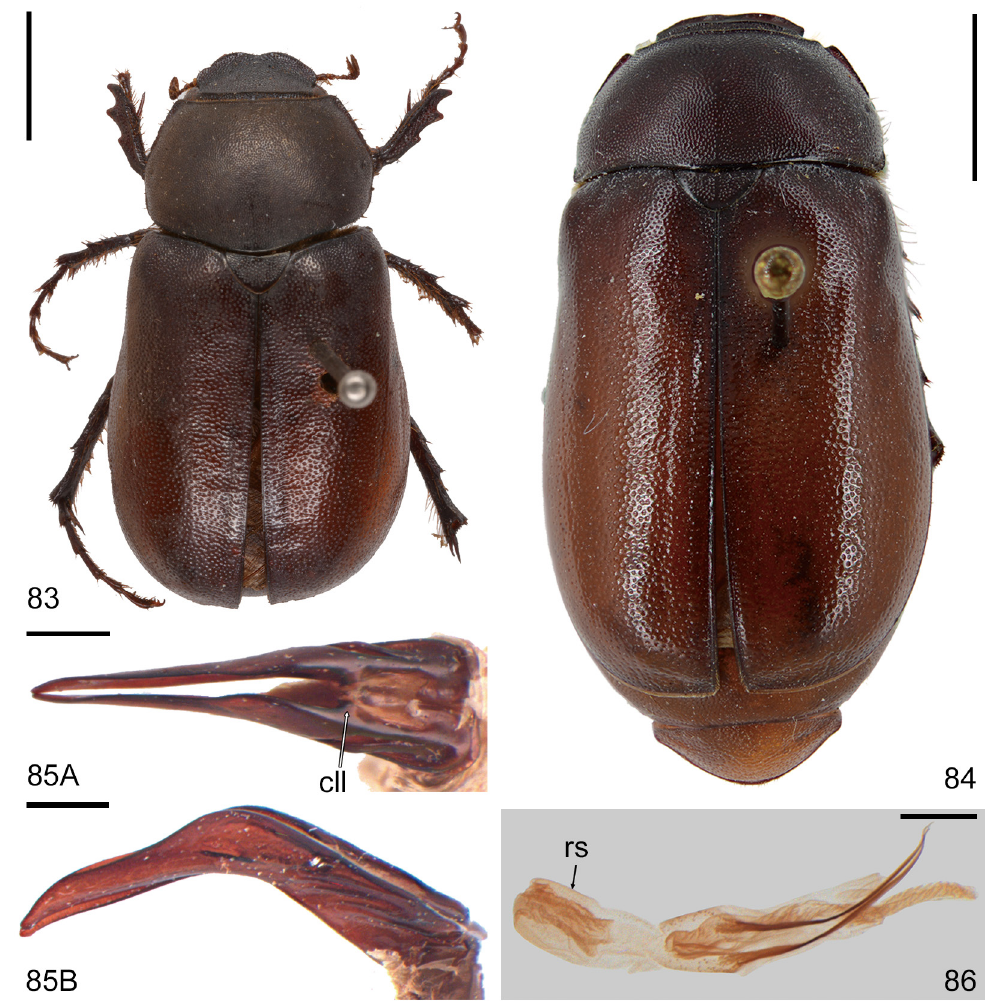
Figs 83–86. 83 . Miridiba sinensis (Hope, 1842), lectotype, ♂ (BMNH). Habitus in dorsal view. 84– 86 . M. pseudosinensis Keith, 2010, holotype, ♂ (DKC). 84 . Habitus in dorsal view. 85 . Parameres in dorsal (A) and lateral (B) views. 86 . Endophallus (everted) and temones in dorsal view. Scale bars: 83–84 = 5.0 mm; 85–86 = 1.0